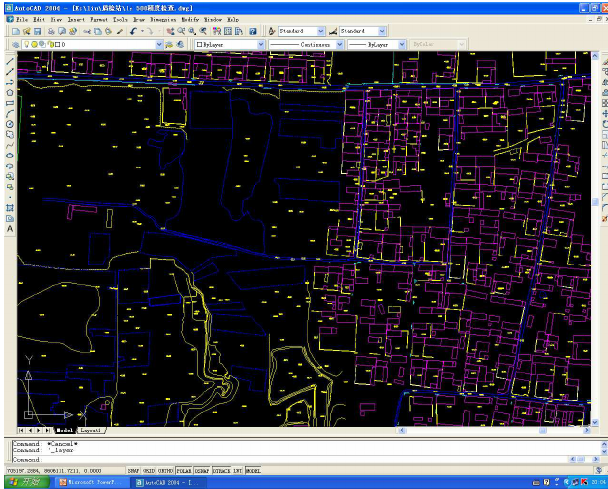
Figure 6: digital map in scale 1:2.000 based on a GSD of 10 cm produced with a Trike